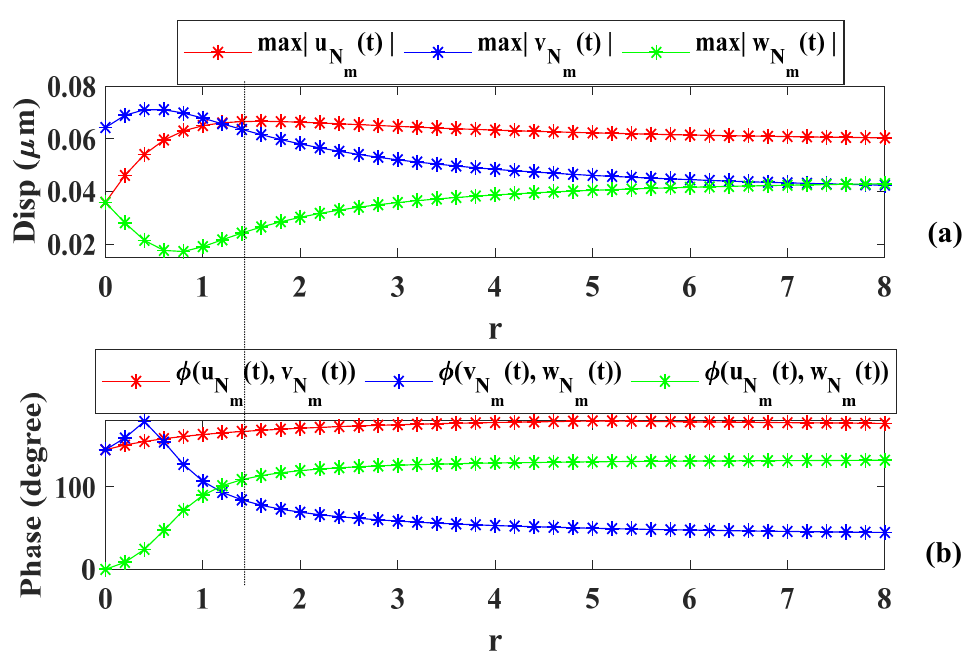
Figure 10. Variations of the ( a ) maximum amplitudes of the last mass ( N m ) of each chain and ( b ) the corresponding phase di ff erences ( φ ) between pairs of chains of the coupled mass-spring waveguides as a function of 𝑟 = |𝐹 (cid:2868)(cid:3048) /𝐹 (cid:2868)(cid:3049) |; 𝐹 (cid:2868)(cid:3048) ,𝐹 (cid:2868)(cid:3049) excitation amplitudes of chain 1 and 2. The third chain is not excited. System parameters: N m = 48, η = 18.24 Ns/m, and (𝐹 (cid:2868)(cid:3048) ,𝐹 (cid:2868)(cid:3049) , 𝐹 (cid:2868)(cid:3050) , 𝜙 (cid:2868)(cid:3049) ,𝜙 (cid:2868)(cid:3050) ) = (𝑟 N, 1 N, 0 N, 𝜋, 0) . The driving frequency is 33.78 kHz.